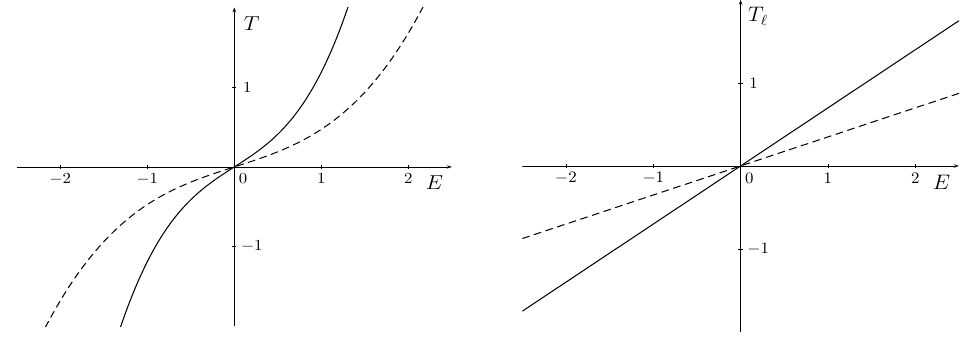
+ ∞ (solid), both for 0 (dashed) and c → →